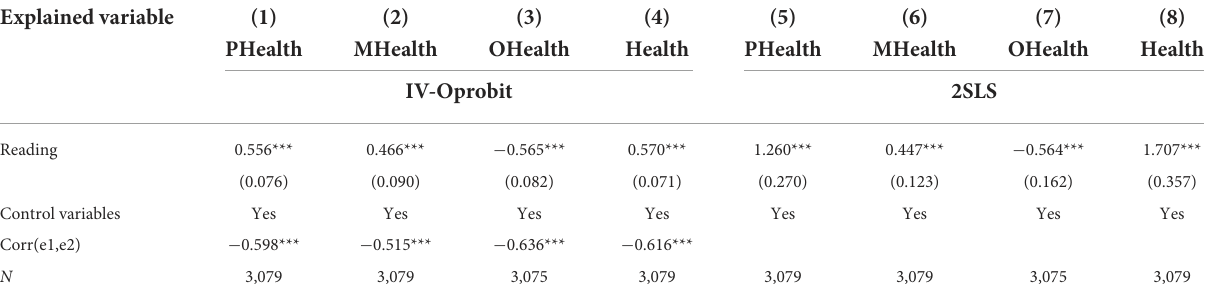
TABLE 7 Robustness test: Replacement of